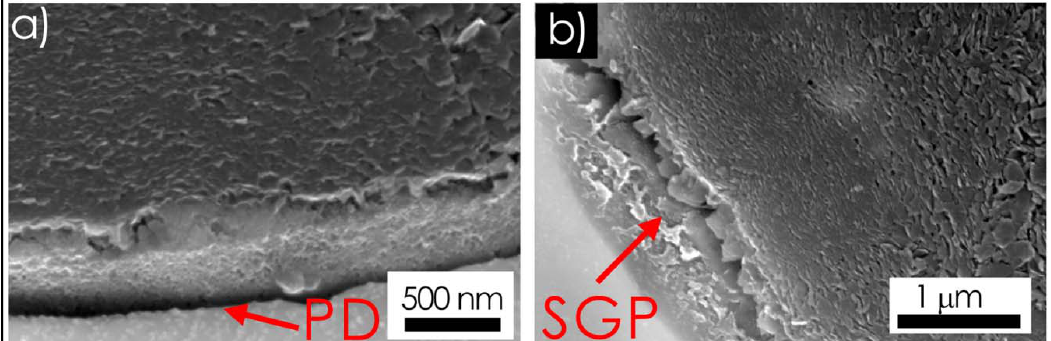
Figure 4. Morphology of graphite/matrix (G ‐ M) interface in S9Ni specimen at a distance of 5 mm from fracture surface, SEM: ( a ) A local pole G ‐ M debonding (PD) at the graphite/ferrite interface, ( b ) a G ‐ M debonding in equatorial area of the graphite/ferrite interface with shifted graphene plates (SGP).